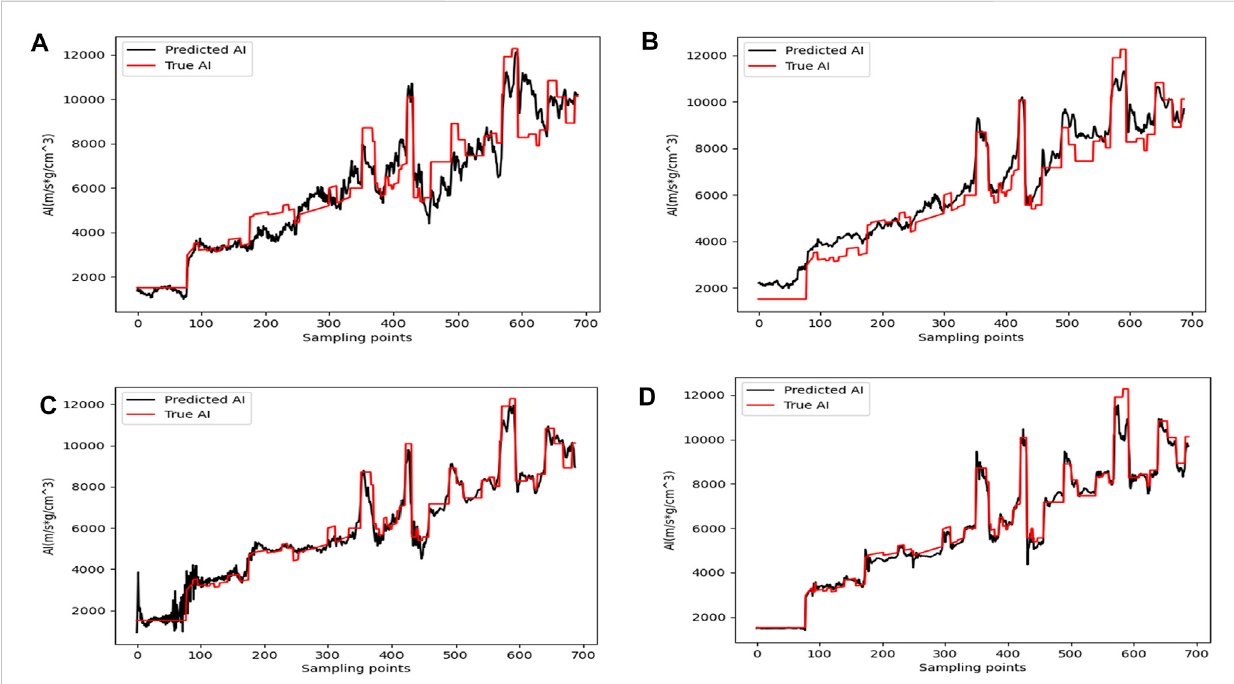
FIGURE 8 Acousticimpedanceinversionresultsoftraceno.1400. (A) InversionresultoftheCNNmethod. (B) InversionresultoftheTCNmethod. (C) Inversion result of the 1D U-Net method. (D) Inversion result of the method in this paper.